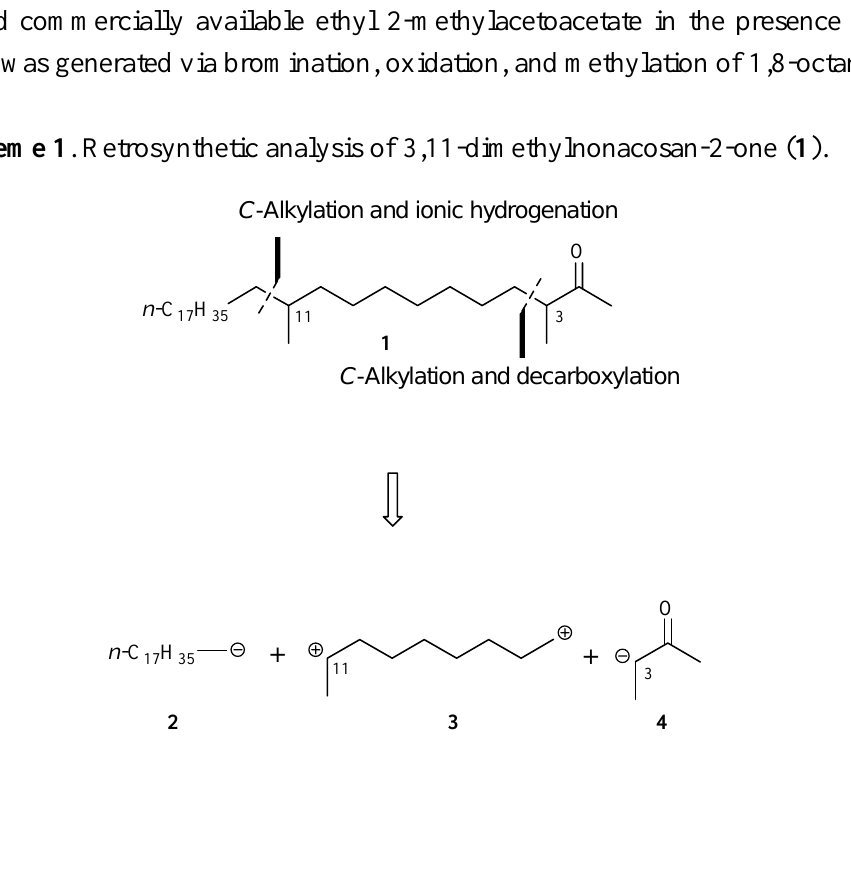
Figure 1 . Structure of 3,11-dimethylnonacosan-2-one ( 1 ) 311 n -C H 17